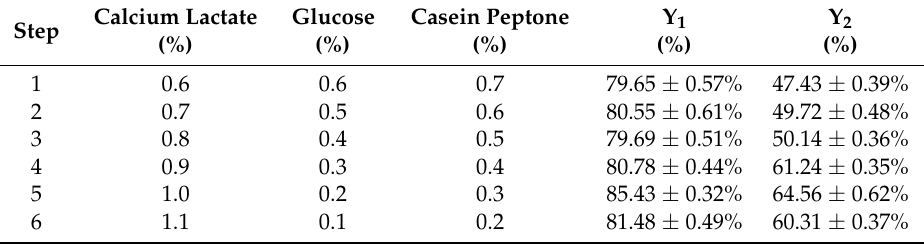
Table 4. Design and results of the steepest ascent experiment for nutrients promoting peptide